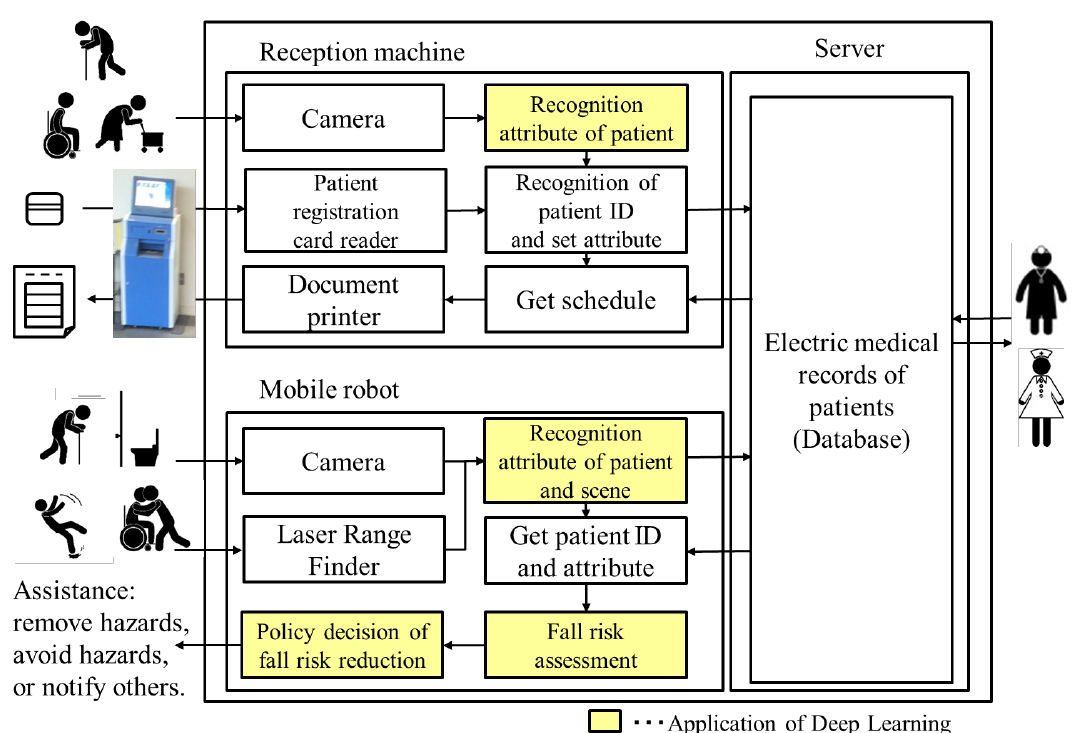
Figure 1. A nursing system preventing patients from falling using deep learning.